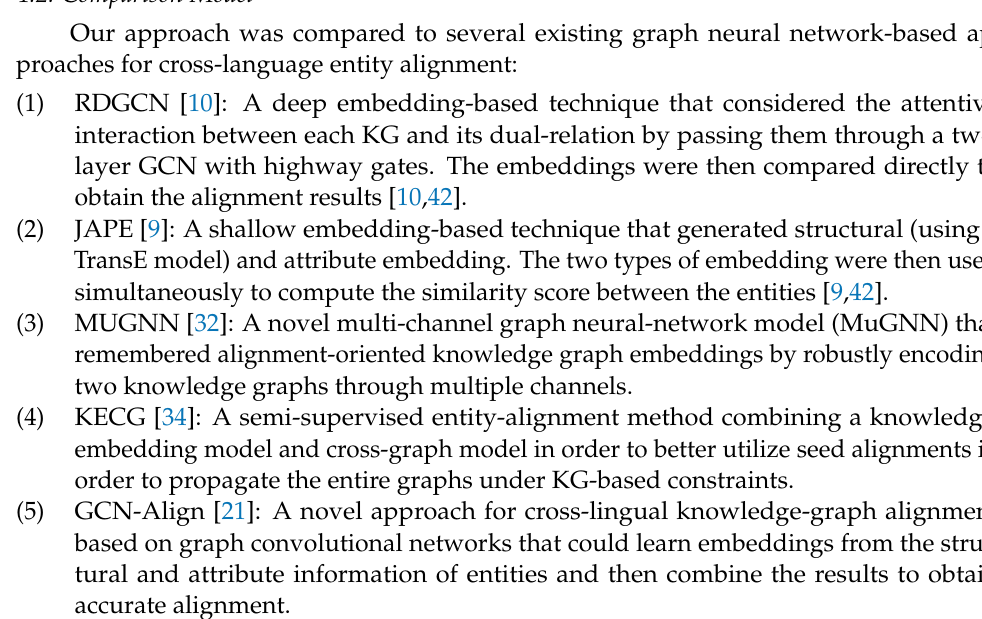
Figure 9. The data format of DBP15K ZH-EN (partial